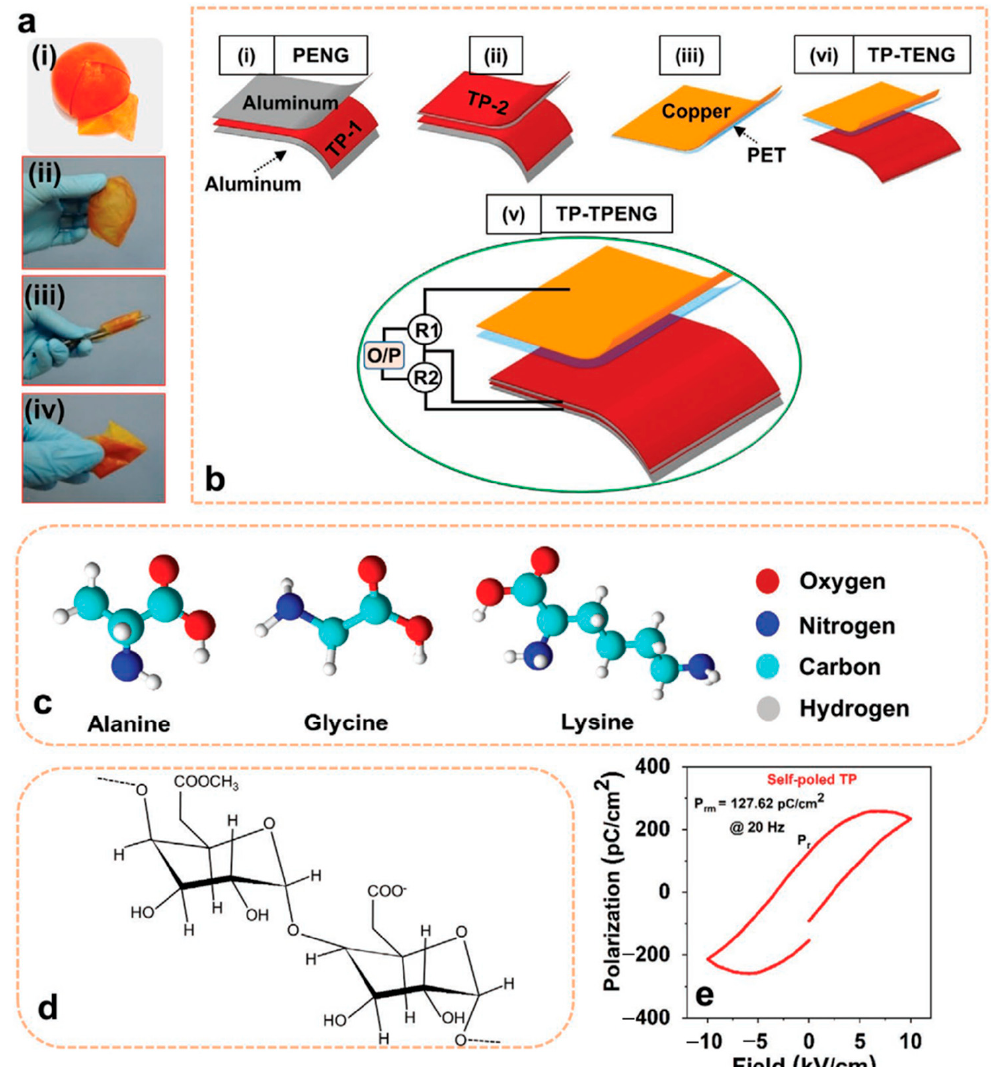
Figure 13. ( a ) Images of ( i ) peeling of a tomato, ( ii ) unfolded TP, ( iii ) folded TP, and ( iv ) rolled TP. ( b ) Schematic view of the main elements and materials used in the hybrid nanogenerator. ( c ) Struc- tures of the three amino acids (alanine, glycine, and lysine) of the TP that allow the presence of C, O, N, and H. ( d ) Schematic view of the carbonyl and hydroxyl groups in the chain of the TP pectin structure. ( e ) Response of TP ferroelectric hysteresis considering a frequency of 20 Hz. Reprinted with permission from [160]. Copyright 2021, John Wiley and Sons.